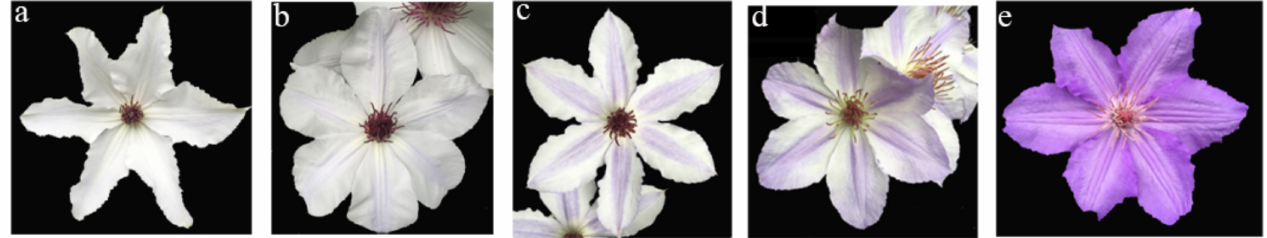
Figure 1. Five C. tientaiensis varieties with different flower colours. ( a ) White (TTCB) flowers; ( b ) lilac and white (TTJD) flowers; ( c ) purple and white (TTJ) flowers; ( d ) dark purple alternate (TTJZ) flowers; ( e ) dark purple (TTSZ)